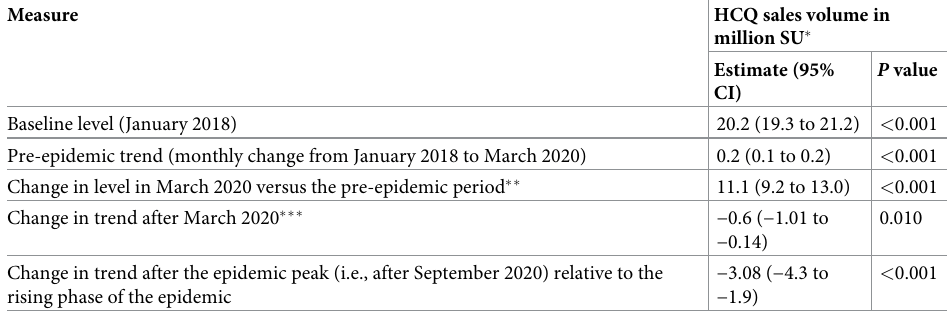
Table 3. Estimated change in monthly sales volume (expressed in million SU) according to adjusted segmented regression models for